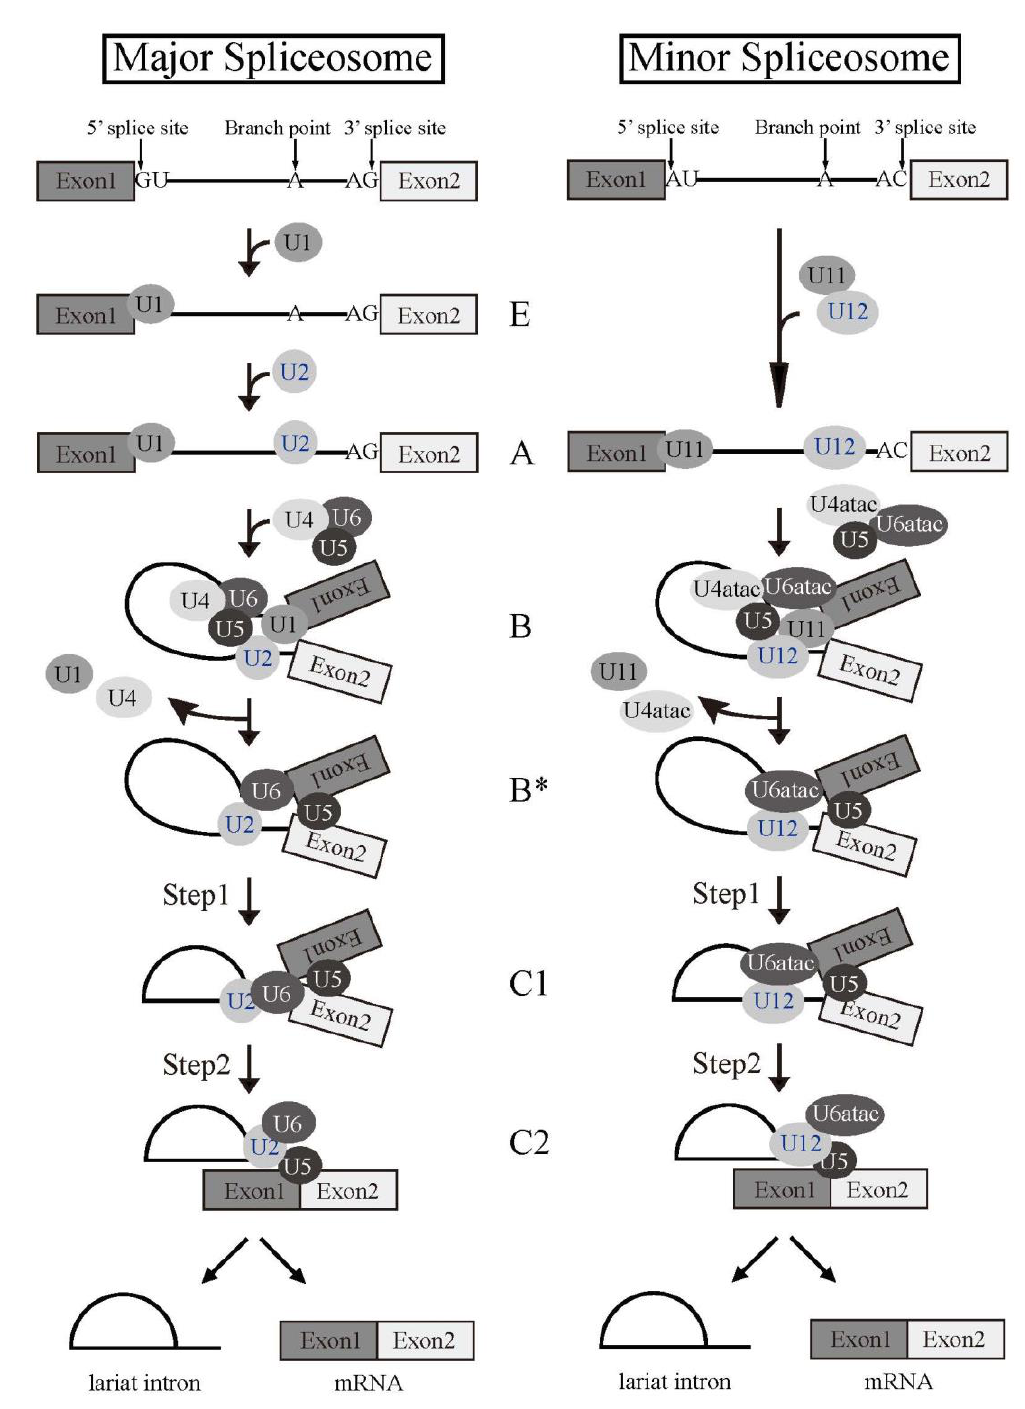
Figure 2. Splicing reaction and formation of spliceosome. Schematic representations of major and minor spliceosome formations. Both splicing reactions take place stepwise in a spliceosome. Spliceosomal Uridine-rich small nuclear ribonucle- oproteins (U snRNPs) are indicated with their names. The name of each spliceosome intermediate complex is shown in the middle.